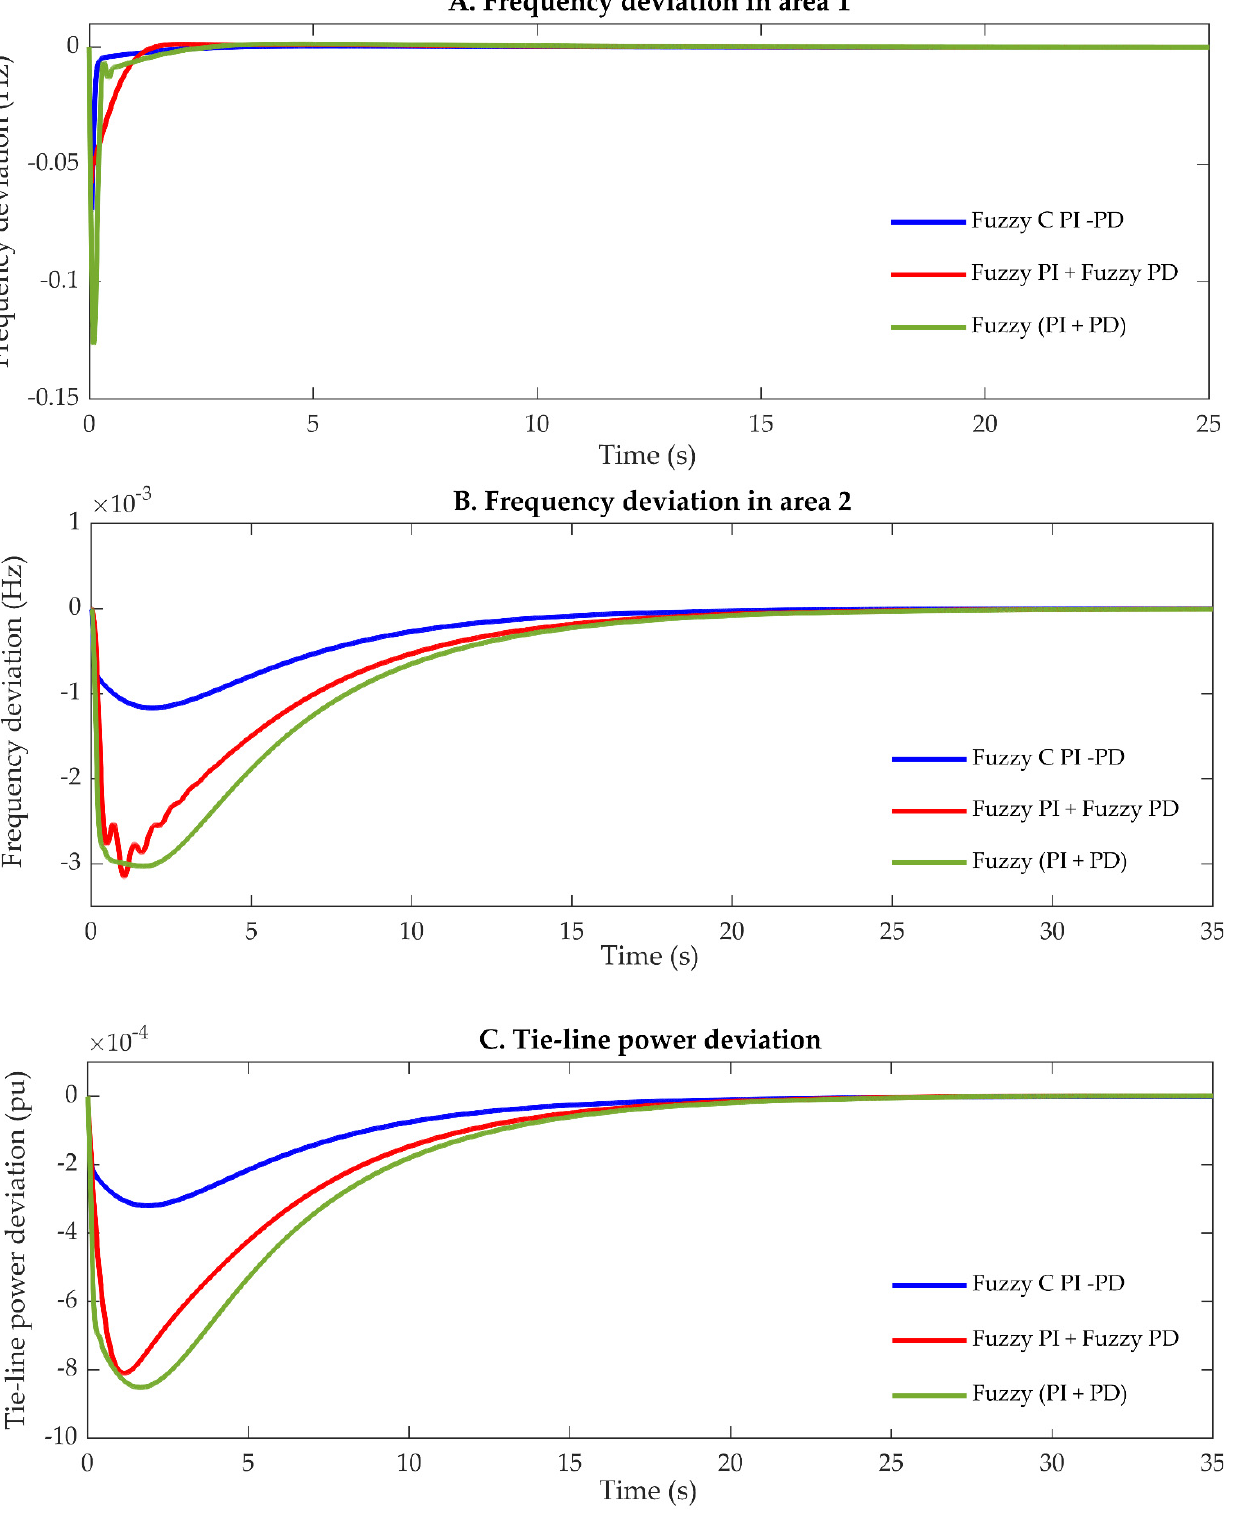
Figure 23. Dynamic response of the testbed power system based on different fuzzy controllers under parametric uncertainty conditions, case 2. ( A ) Frequency variation in area 1; ( B ) frequency variation in area 2; ( C ) tie-line power variation.